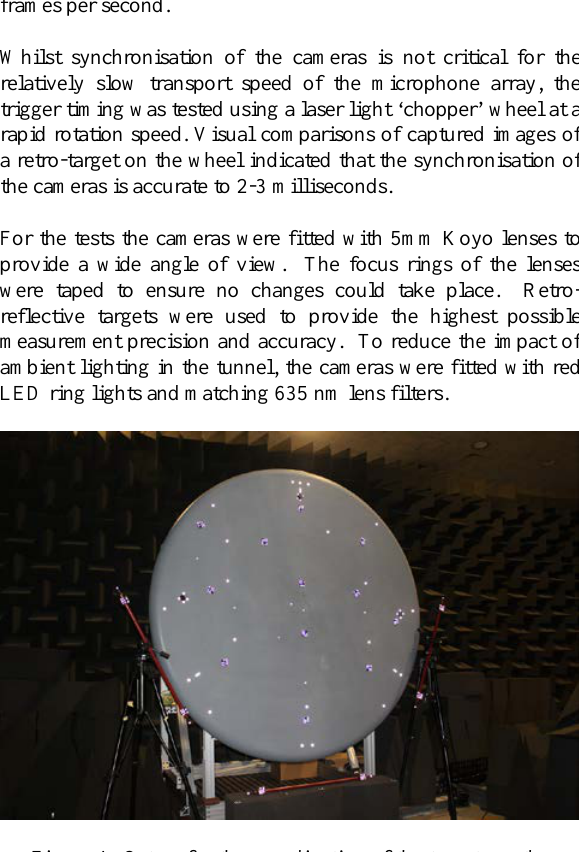
Figure 4. Set up for the coordination of the targets on the surface of the microphone array